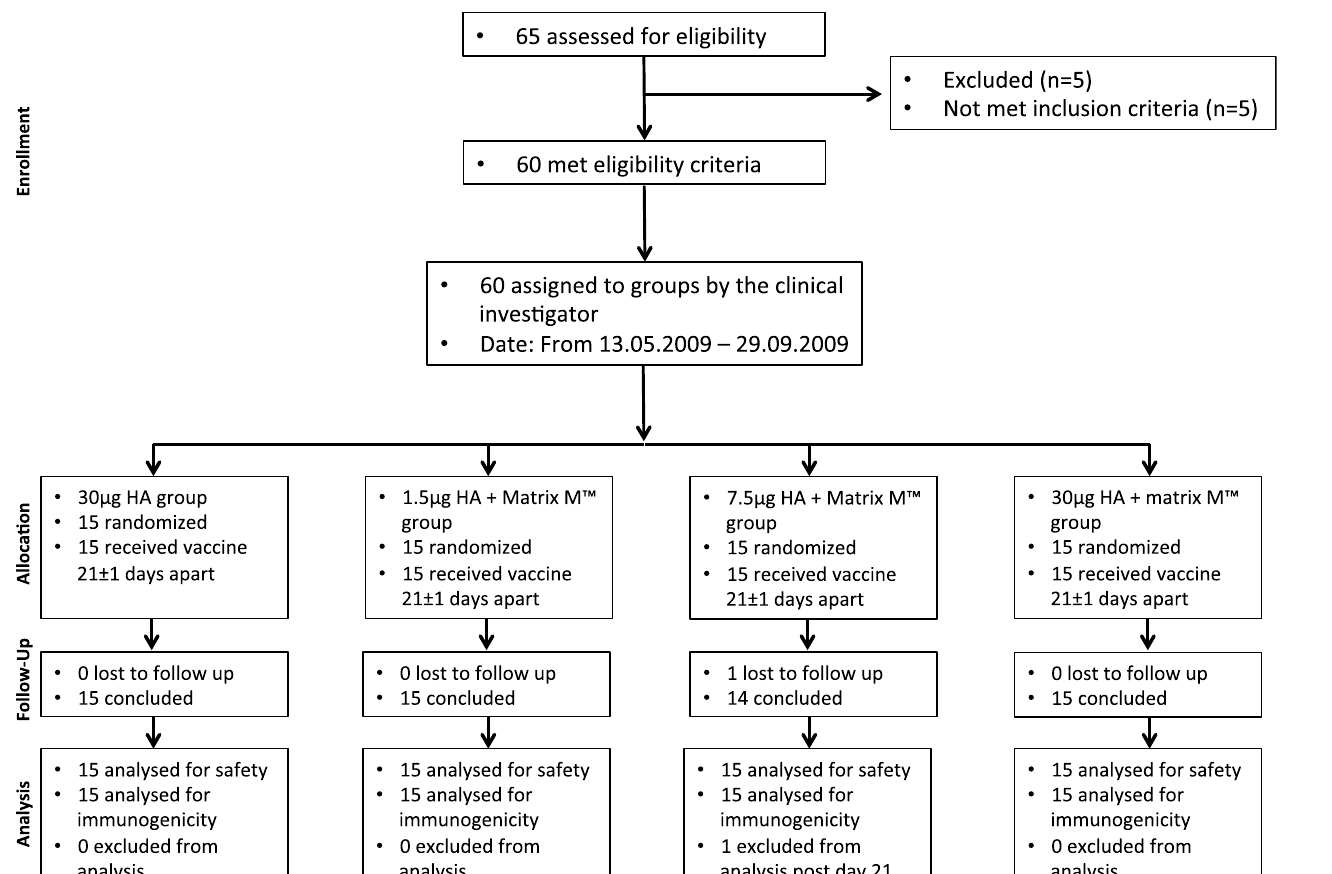
Fig 1. CONSORT flowchart. In total, 65 adult subjects were assessed for eligibility and 60 were included in the study (mean age 31 years old, 60% female). Prior to being enrolled in the study, all participants provided written informed consent and were screened for normal haematology, biochemistry and immunology parameters. The 60 volunteers were randomised into four groups and were immunised twice, 21 days ( ± 1) apart with the virosomal H5N1 vaccine alone (30 μ g HA) or with vaccine (1.5, 7.5 or 30 μ g HA) formulated with Matrix-M (50 μ g) adjuvant. Blood samples were collected at 7, 14 and 21 days after each dose of vaccine and 180 and 365 days after the first